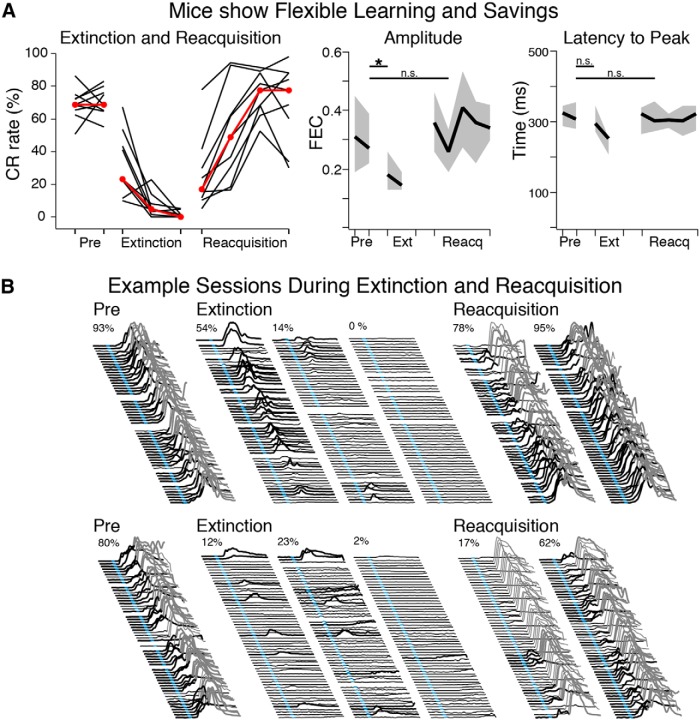
Mice efficiently extinguished learned responses, and showed savings during reacquisition. A, CR rates for mice during asymptotic performance (Pre), and for extinction and reacquisition sessions. Mice (n = 9) decreased CR rates to <5% within three extinction sessions, and reacquired CRs faster than during initial acquisition (“savings”; left graph, red markers show median CR rate for each session). Decreases in CR rate were accompanied by decreases in amplitude (middle graph, median ± IQR, t = 3.21, df = 8, p = 0.01), but not by differences in CR peak latencies (right graph, median ± IQR, t = 0.10, p = 0.92). B, Example extinction and reacquisition sessions from two mice. For extinction, some mice decreased CRs gradually (top) while others showed more abrupt changes in behavior (middle). Note the decrease in CR amplitude during extinction sessions, whereas the timing of CRs was maintained. All mice met learning criterion (>50% CRs) within one to three reacquisition sessions. Some mice showed gradual learning during a session (top), whereas others increased expression between sessions (bottom).